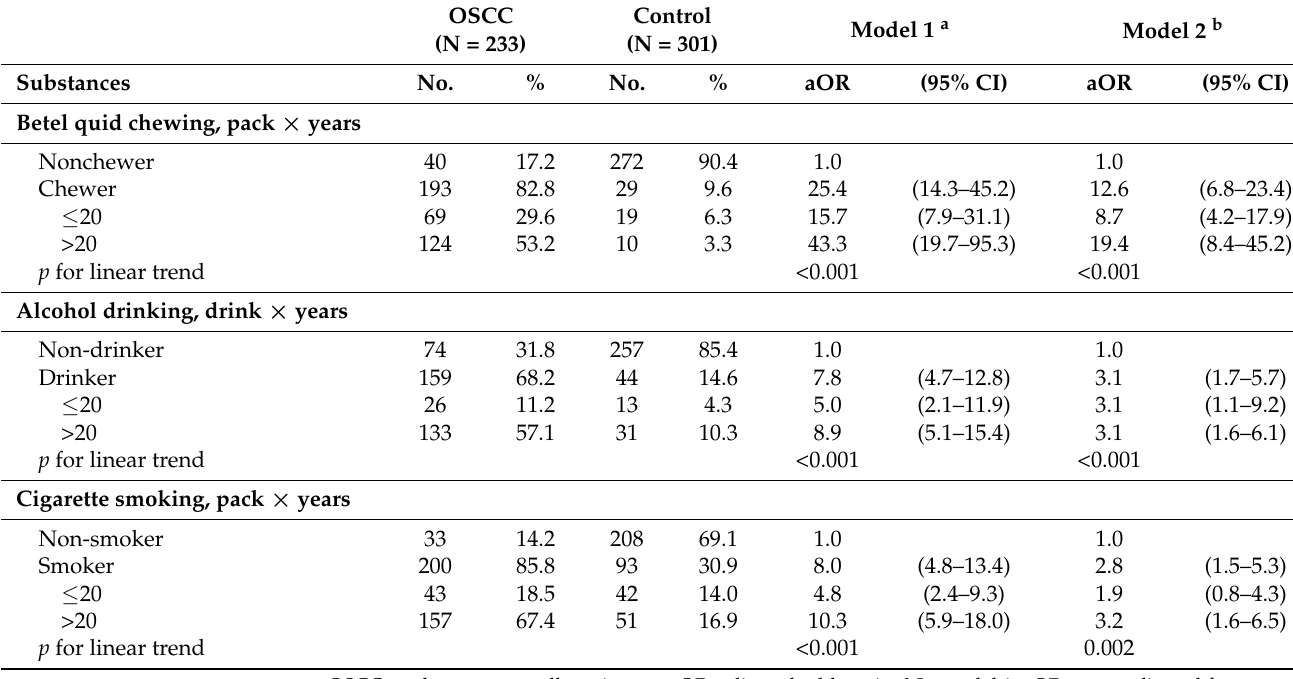
Table 3. Adjusted odds ratios of oral squamous cell carcinoma associated with substance